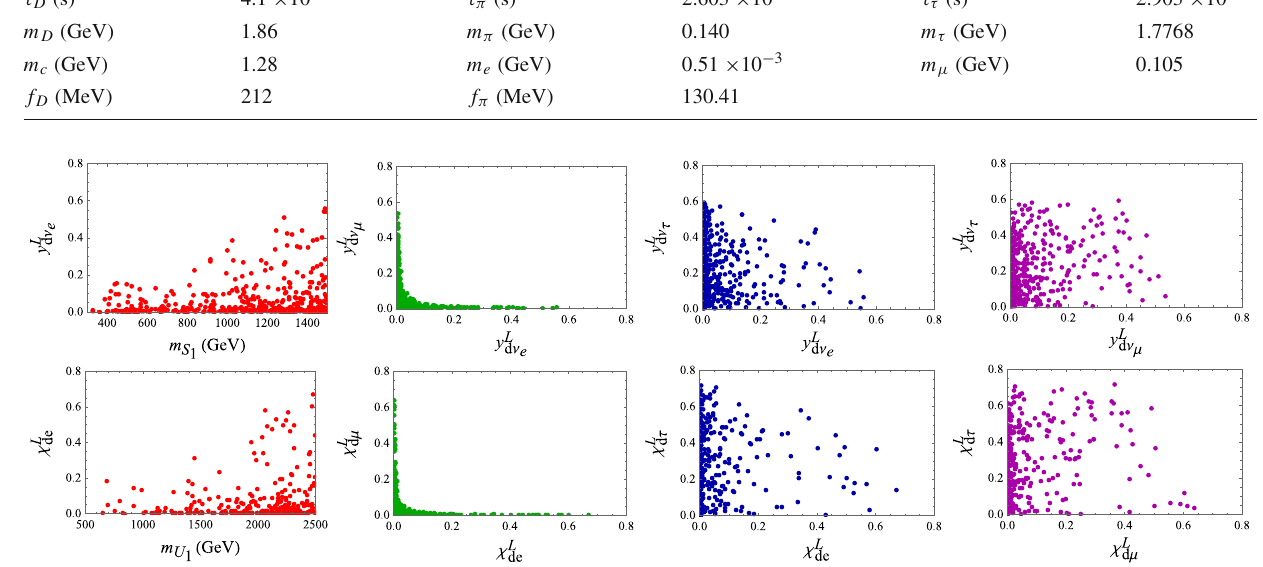
Fig. 1 The allowed parameter space after taking into account the results from the most relevant low-energy flavor experiments with the experimental result R π 10 − 4 and the SM value R π